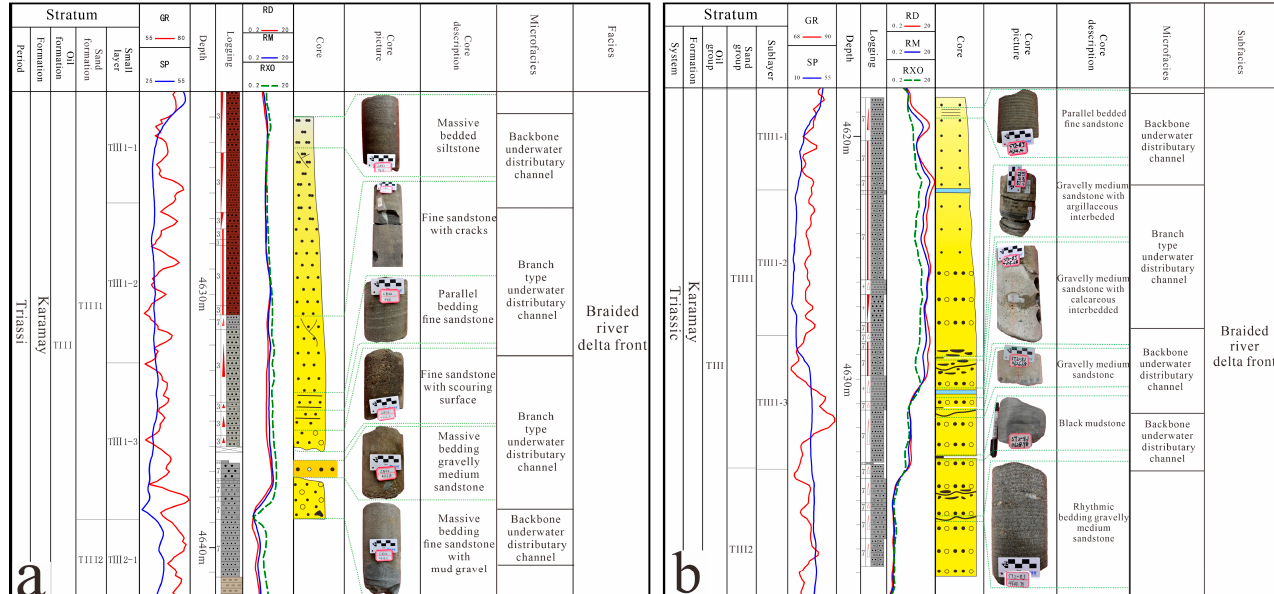
Figure 7. Single well architecture interpretation in the Sangtamu oilfield (( a ) well LN22, ( b ) well ST2-8J).